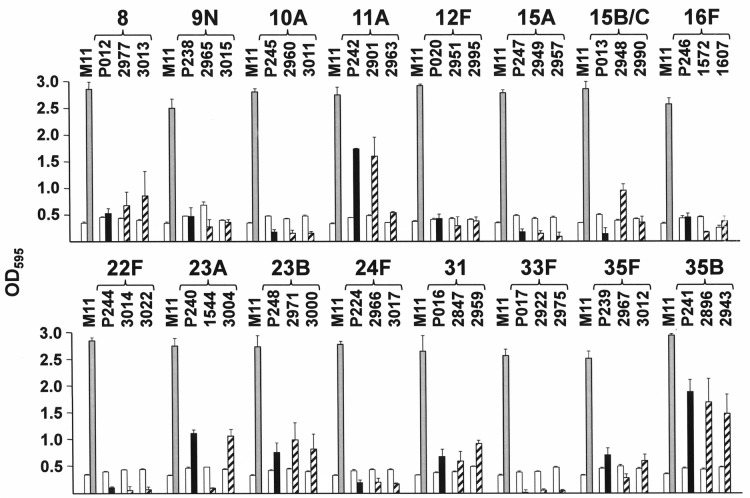
Biofilm formation.Growth and biofilm formation by S. pneumoniae clinical isolates of the indicated serotypes, and their encapsulated M11 transformants. In all cases, open bars indicate bacterial growth. Hatched and blackened bars indicate, respectively, biofilm formation by either clinical isolates or their encapsulated M11 transformants. Grey bars correspond to biofilm formation by the M11 strain. Biofilm formation by the M11 strain was determined in all experiments with mean values between serotypes that were not significantly different (P >0.05 using one-way ANOVA).